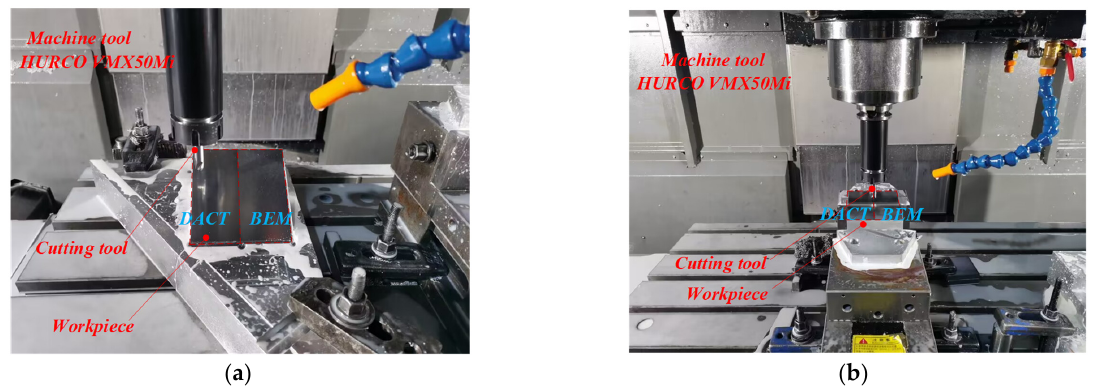
Figure 16. Machine tool and cutting tools: ( a ) inclined plane; ( b ) concave–convex ruled surface. In addition, a Kister 9171A revolving dynamometer and a VDL-1000E machine were adopted in the test process to collect the cutting force, as shown in Figure 17.